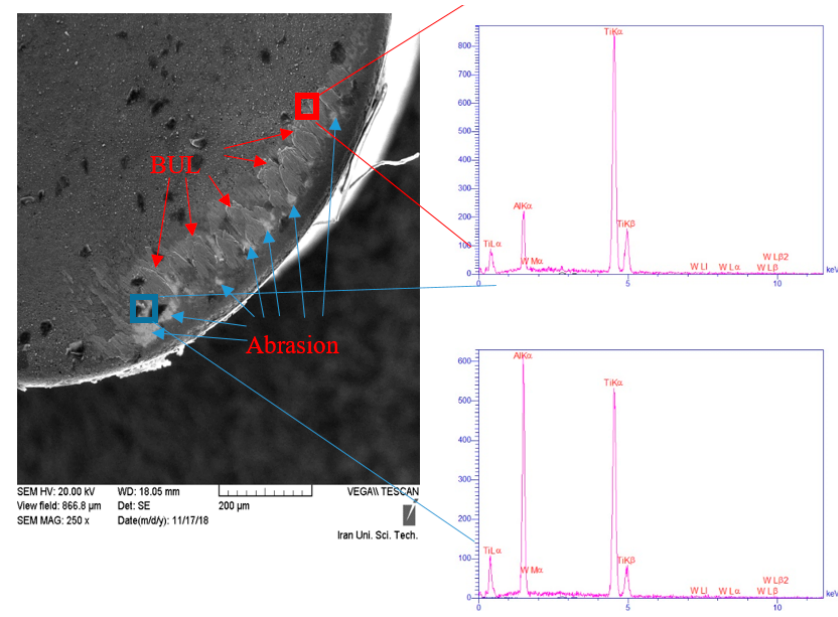
Figure 3. SEM and EDX images for insert 1 (TS2000) after 0.5 s of cutting.